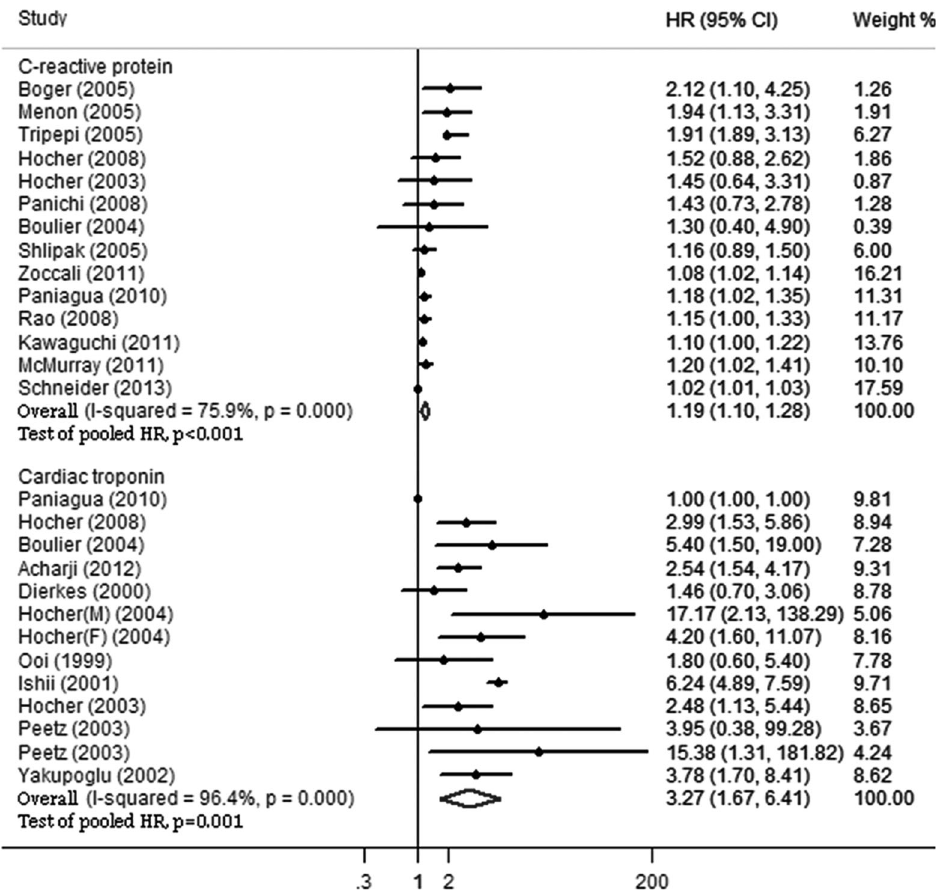
Figure 3 - C-reactive protein and cardiac troponin for predicting cardiovascular mortality. Elevated serum levels of C-reactive protein and cardiac troponin were significantly associated with cardiovascular mortality in patients with chronic kidney disease. However, the pooled HR of cardiac troponin was higher than that of C-reactive protein. HR, hazard ratio; CI confidence